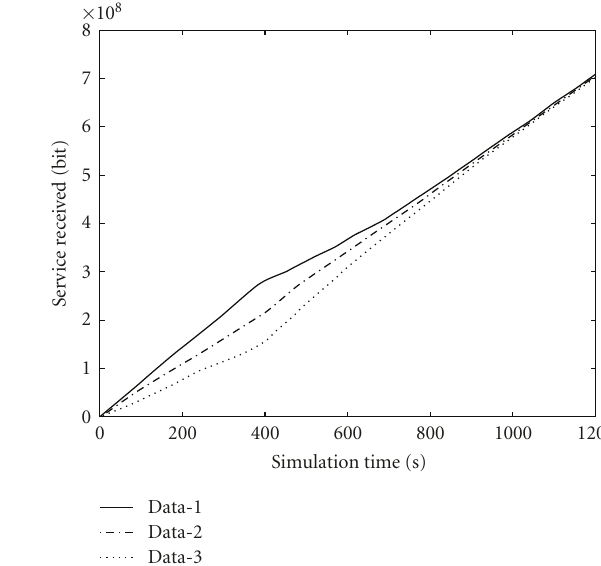
Figure 9: Service received by data sessions in NDPS.